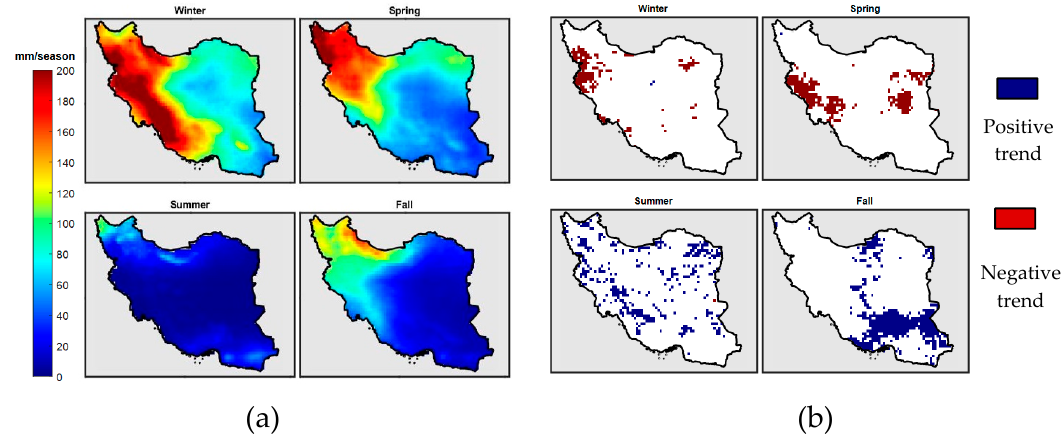
Figure 3. ( a ) Spatial patterns of mean seasonal precipitation in millimeters for the period 1983 to 2018; ( b ) spatial distribution map of trends in the seasonal precipitation based on PERSIANN-CDR for the same period.